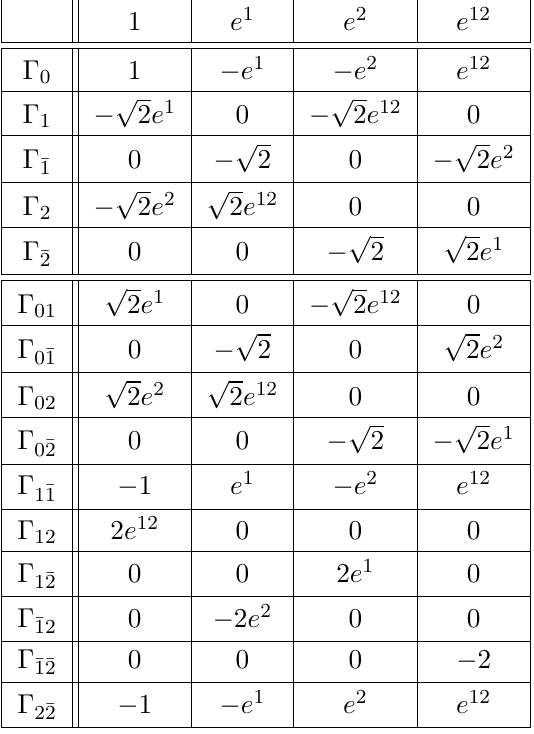
Table 1 . The action of the gamma matrices and the Spin(1 ; 4) generators on the di(cid:11)erent basis